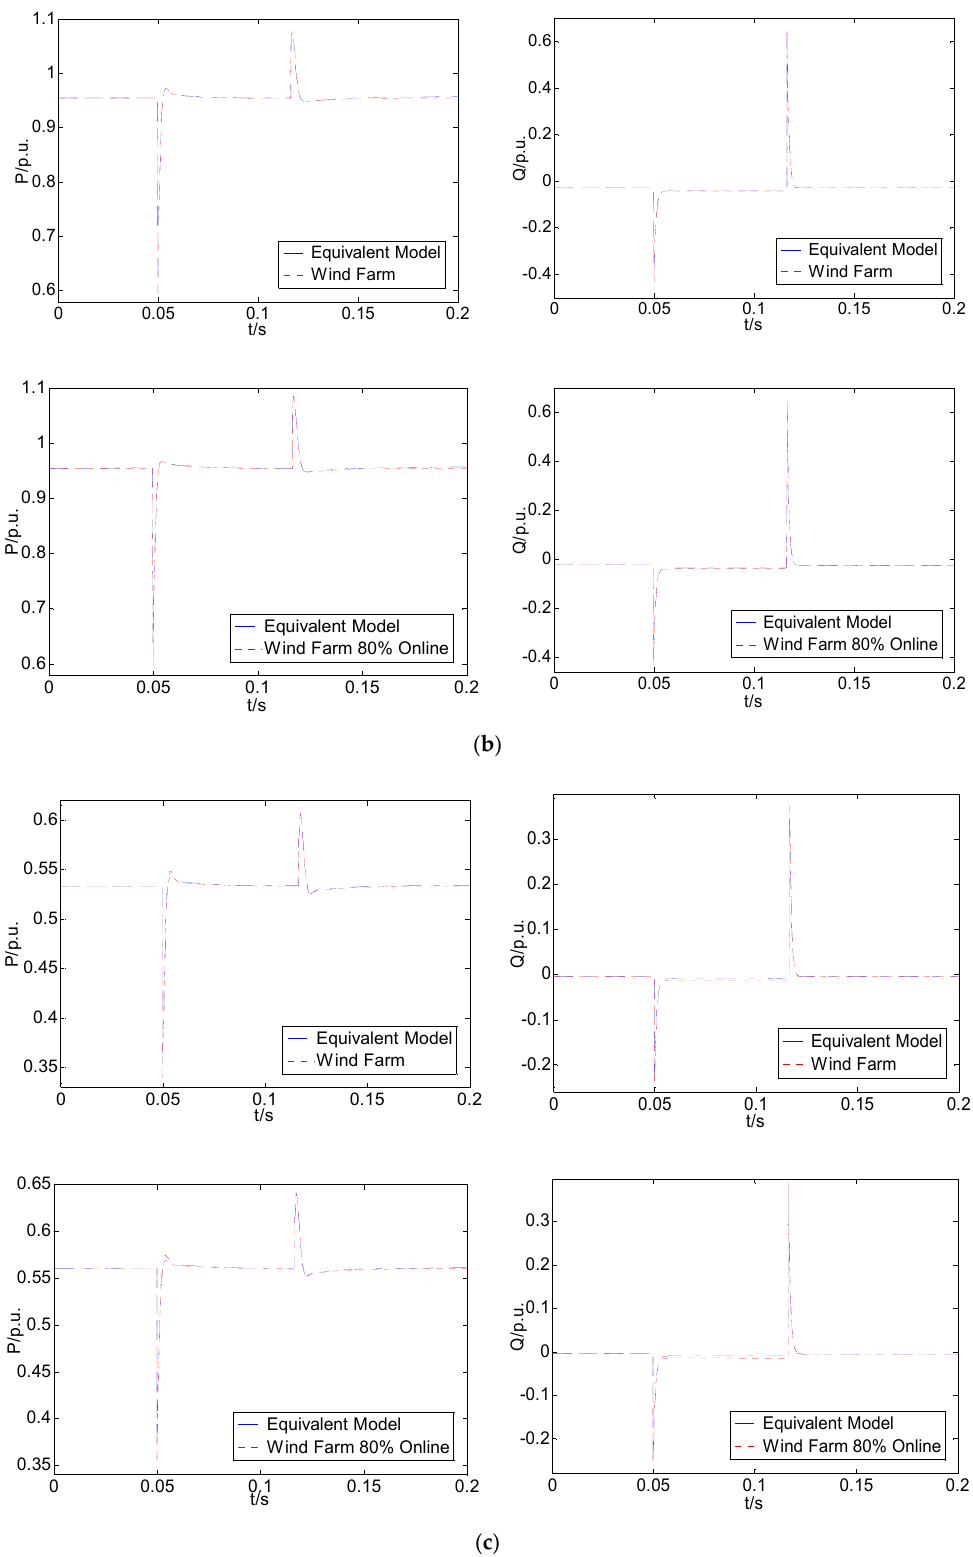
Figure 8. Generalization ability of equivalent model: ( a ) comparison response for wind speed is 7 m / s; ( b ) comparison response for wind speed is 12 m / s; and ( c ) comparison response considering wake e ff